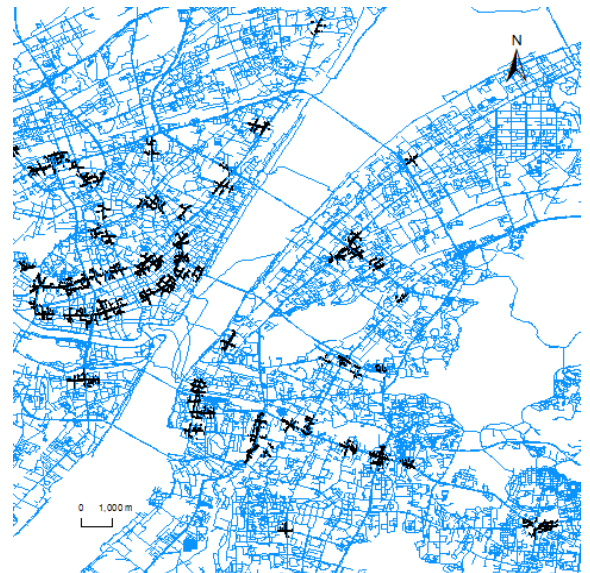
Figure 2. POIs in Dense Area